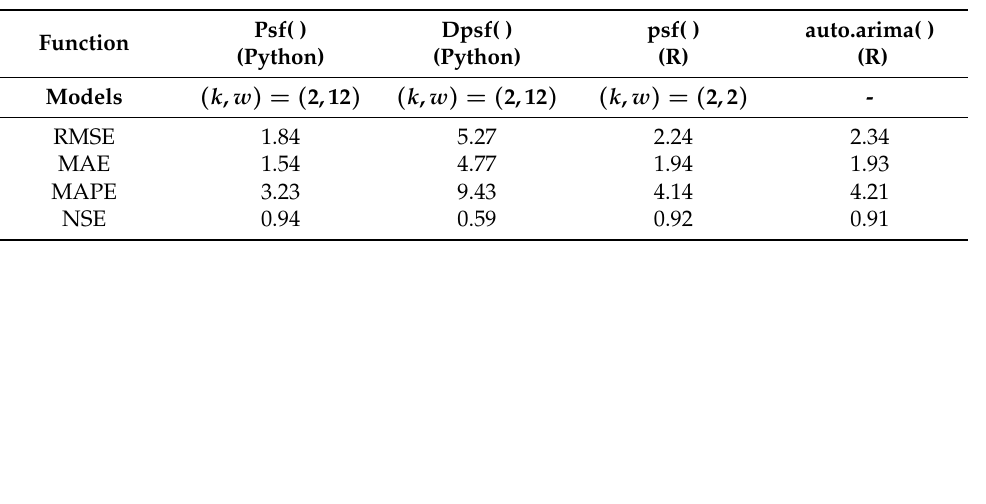
Figure 3. Result of psf_plot() for the “nottem” dataset. Table 2. Comparison of forecast methods with different error metrics for the “nottem”